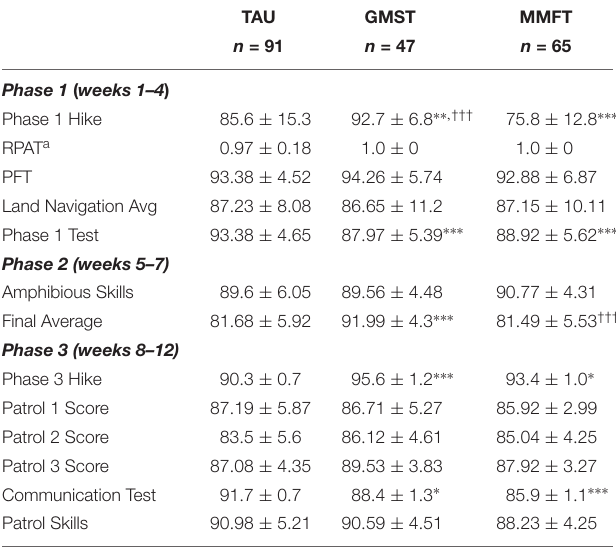
TABLE 2 | Performance metrics during Marine Corps’ Basic Reconnaissance